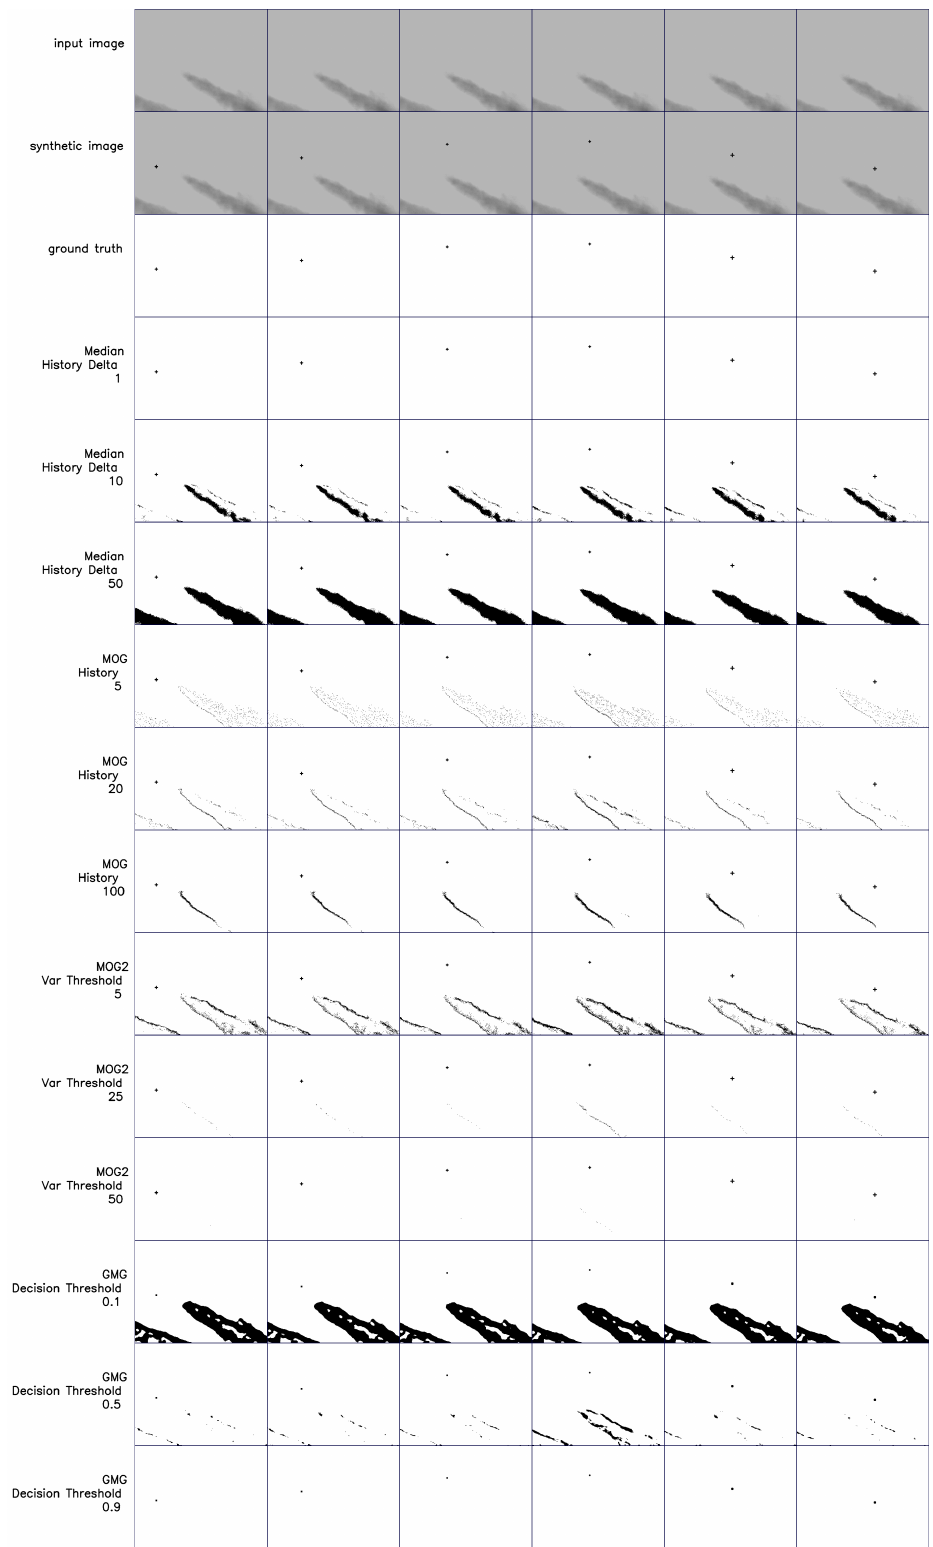
Figure 6. Influence of example algorithm parameters on the detection process (part 1) (GMG (Godbehere-Matsukawa-Goldberg), MOG (Mixture of Gaussian), MOG2 (Mixture of Gaussian ver- sion